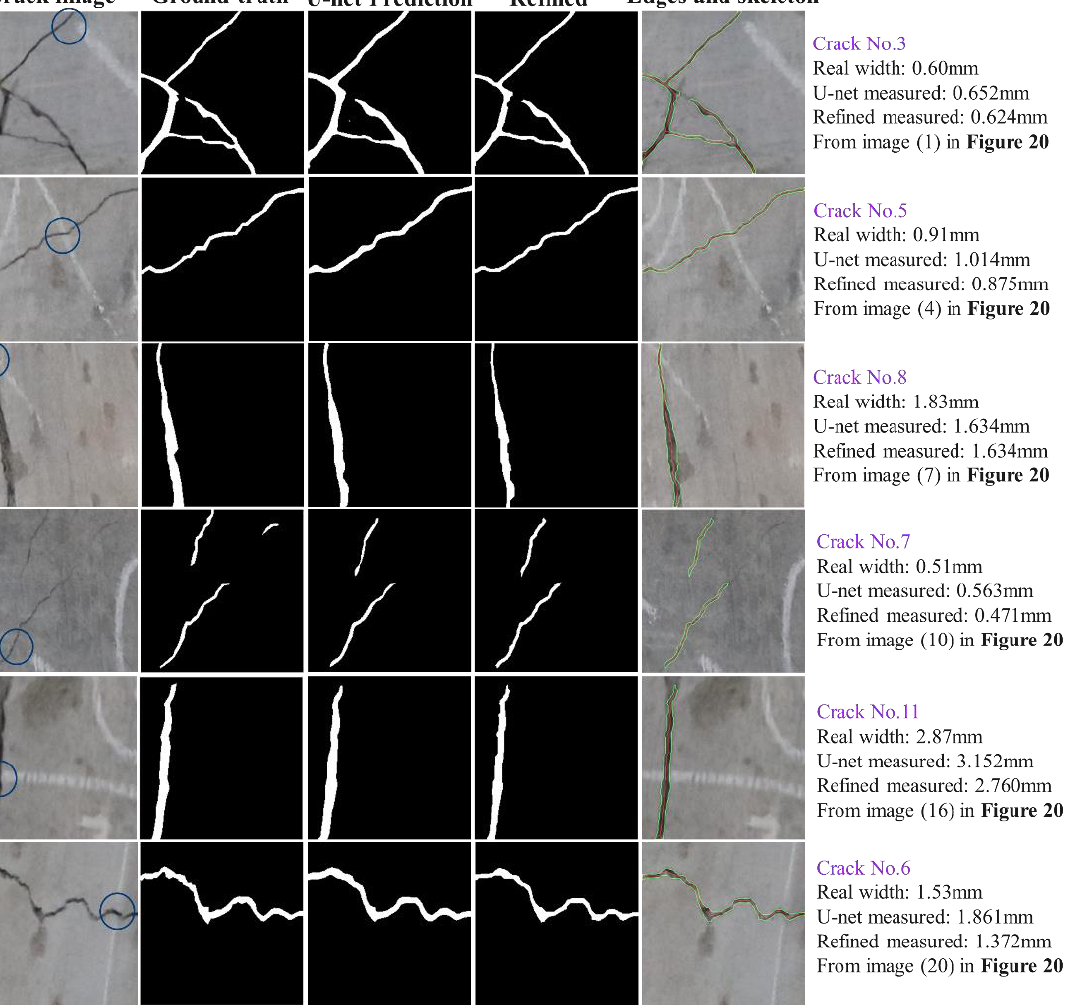
Figure 22. Measurement results of each crack in each image, and the real widths of 12 cracks. Of these, crack no. 1 is not detected in image 6, image 7 and image 19; crack no. 7 is not detected in image 6, image 7, image 19 and image 20.